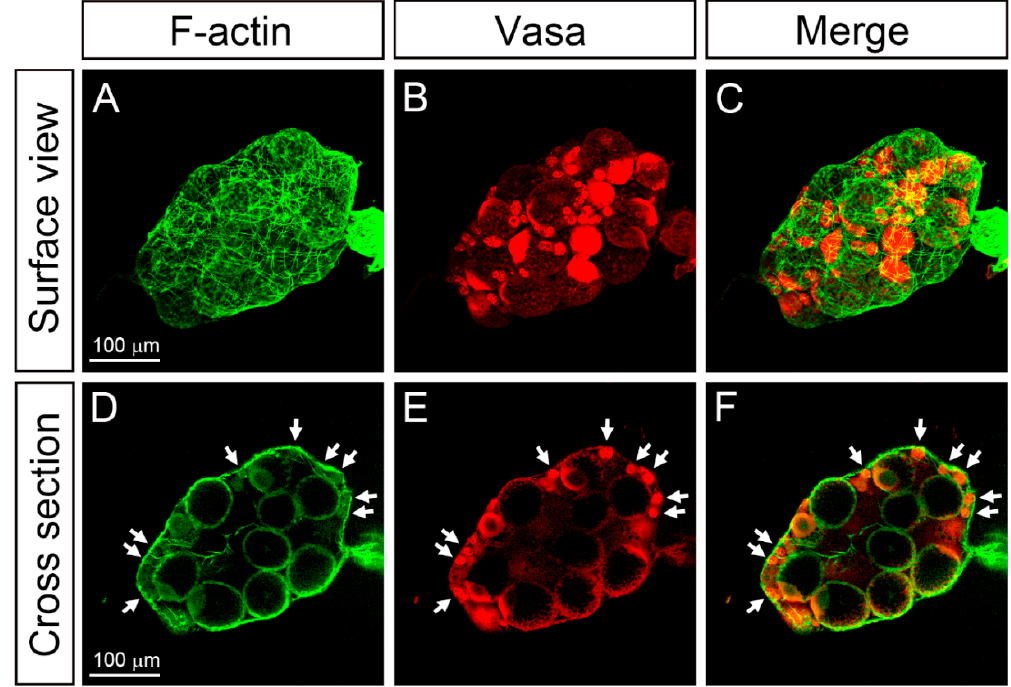
Figure 3. The ovarian structure and the alignment of ovarioles within the ovary of F. taiwana. ( A – F ) Confocal micrographs showing the ovarian structure of F. taiwana at 15 h post-blood meal. The F-actin was revealed by phalloidin staining (green), whereas the germline cells were marked by polyclonal rabbit anti-Vasa antibody (red). ( A – C ) The surface view revealed the F-actin enriched ovarian sheath ( A ) and germ line cells ( B ). ( C ) Merged image. ( D – F ) The optical cross-section showed that the germarium of each ovariole (arrows in E) was bound to the ovarian sheath (arrows in D). ( E ) Merged image.